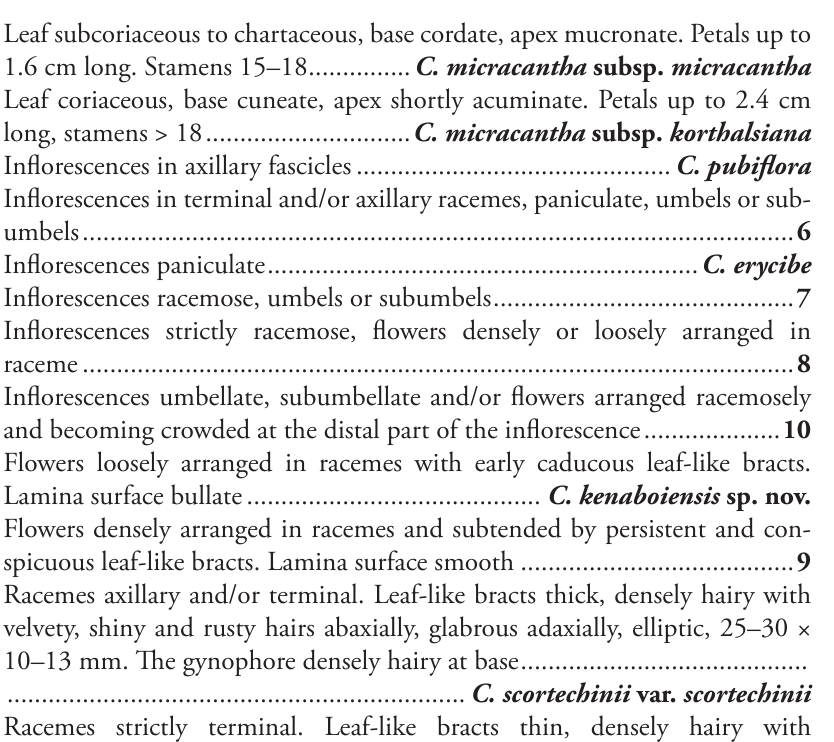
Inflorescences strictly racemose, flowers densely or loosely arranged in – Inflorescences umbellate, subumbellate and/or flowers arranged racemosely and becoming crowded at the distal part of the inflorescence .................... 10 Flowers loosely arranged in racemes with early caducous leaf-like bracts. – Flowers densely arranged in racemes and subtended by persistent and con- spicuous leaf-like bracts. Lamina surface smooth ........................................ 9 9 Racemes axillary and/or terminal. Leaf-like bracts thick, densely hairy with velvety, shiny and rusty hairs abaxially, glabrous adaxially, elliptic, 25–30 × 10–13 mm. The gynophore densely hairy at base .......................................... – Racemes strictly terminal. Leaf-like bracts thin, densely hairy with tomentose, straw hairs on both surfaces, soon glabrescent abaxially with age, narrowly elliptic, (10–)13–25 × (1–)2–8 mm long. The gynophore glabrous 10 Inflorescences in racemes and/or subumbels, terminal sometimes axillary, – Inflorescences in umbels, lateral or axillary sometimes terminal, sepals gla- 11 Lamina subcoriaceous to coriaceous, broadly ovate sometimes ovate-elliptic, 13–16 × 5.5–8.5 cm, drying leaves reddish brown rarely pale green with pale yellow rarely dark red venation on both surfaces, intercostal veins obscure. Inflorescence terminal with flowers arranged racemosely and becoming crowded at the distal part of the inflorescence, stamens 30–40 ...................... – Lamina chartaceous, oblong-elliptic or broadly lanceolate, (5–)10–14(–19) × (2–)3.5–8.5 cm, drying leaves dull green with brownish main nerves on both surfaces, intercostal veins irregular reticulate and distinct. Inflorescence terminal with flowers arranged racemosely and becoming crowded at the distal part of the inflorescence, sometimes subumbellate on 3–4 cm long peduncles in the axils of the uppermost leaves, stamens (30–)60–70 .............